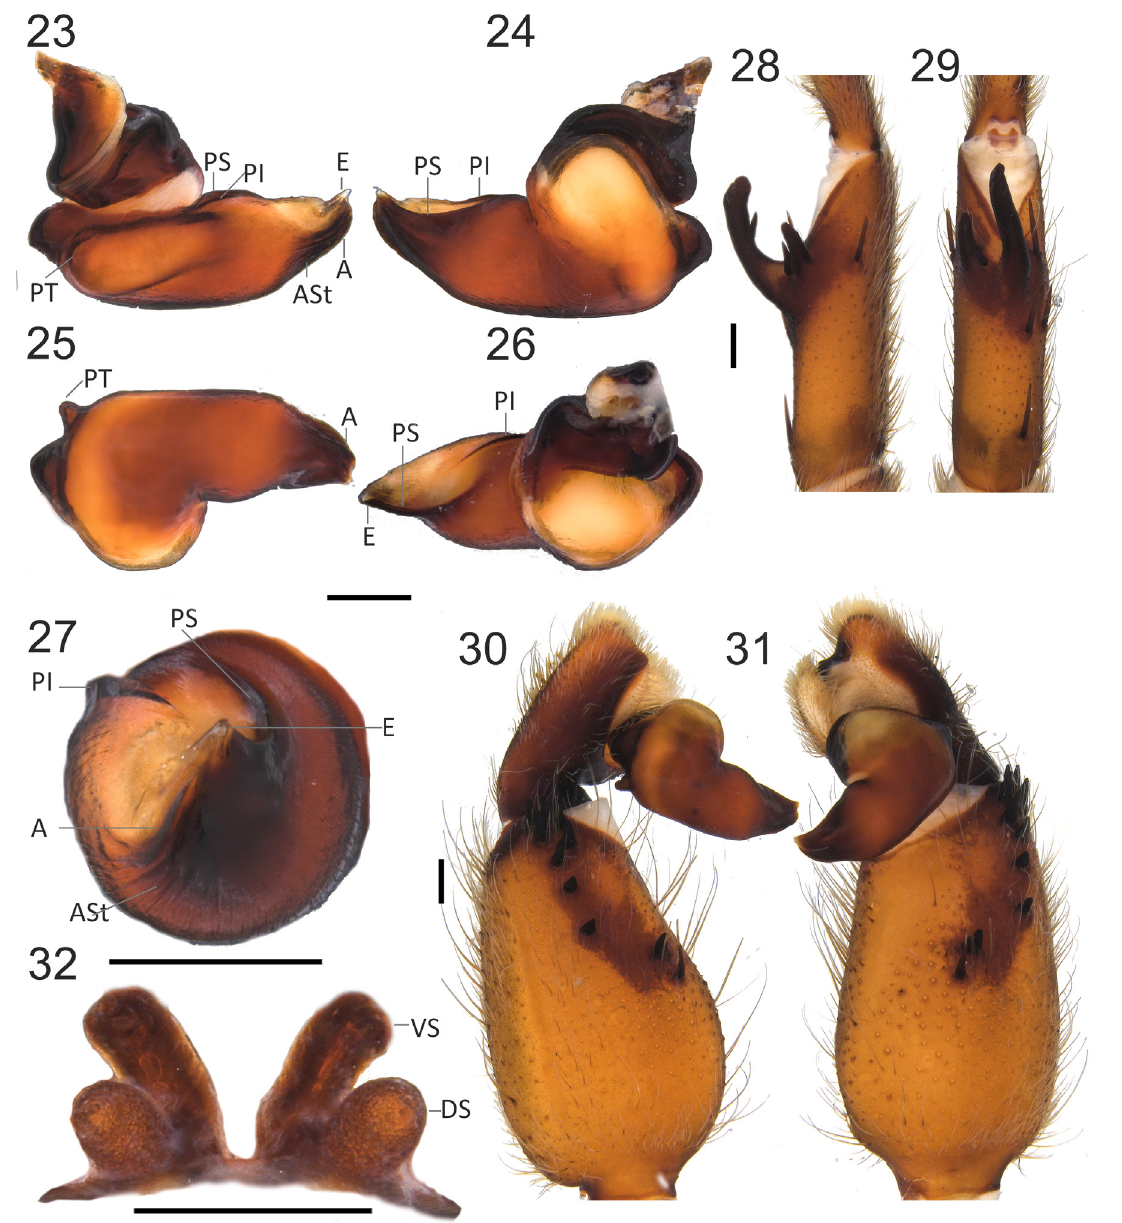
Figs 23–32 . Schismatothele caeri sp. nov. 23–31 . Holotype, ♂ (MZSP 47440). 23–27 . Palpal bulb, prolateral (23), retrolateral (24), ventral (25), dorsal (26), and frontal (27) views. 28–29 . Tibial spur, prolateral (28), and ventral (29) views. 30–31 . Palpal tibiae, right (30), and left (31). 32 . Paratype, ♀ (MZSP 47427). Spermathecae, ventral view. Abbreviations: A = apical keel; ASt = apical striae; DS = dorsal receptacle; E = embolus; PI = prolateral inferior keel; PS = prolateral superior keel; PT = prolateral tegular apophysis; VS = ventral receptacle. Scale bars = 0.5